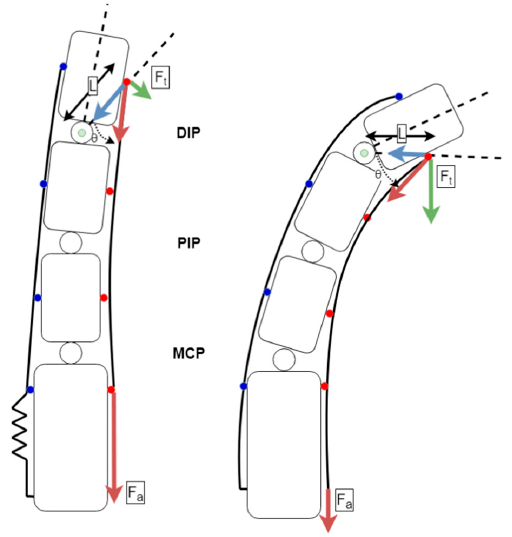
Figure 1. Un-actuated ( left ) and actuated ( right ) finger showing artificial tendon attachment points and fingertip force diagram.